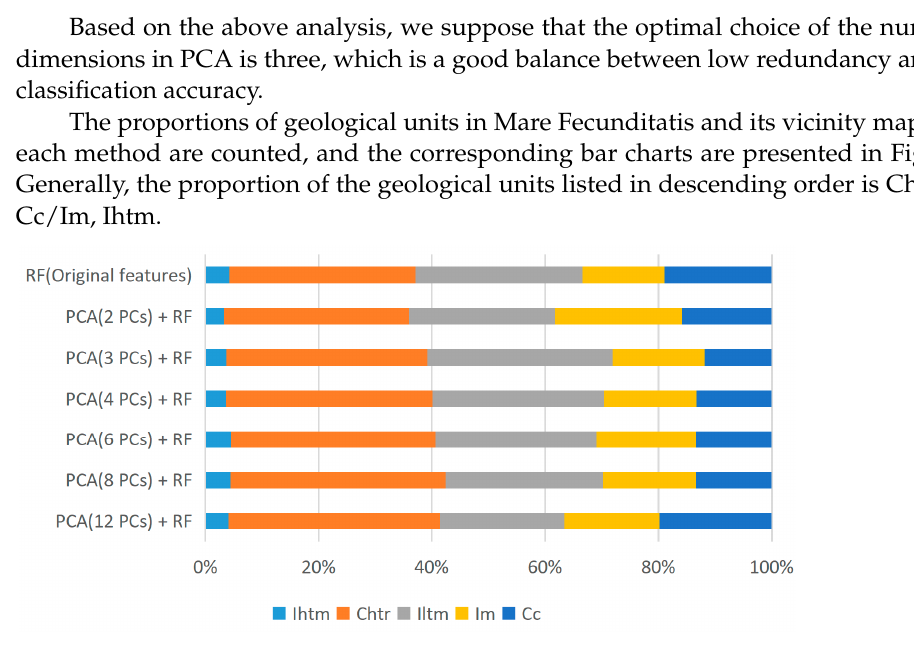
Figure 15. Classification results obtained by PCA + RF with different numbers of PCs. ( a ) Two PCs; ( b ) Three PCs; ( c ) Four PCs; ( d ) Six PCs; ( e ) Eight PCs; ( f ) All 12 PCs.